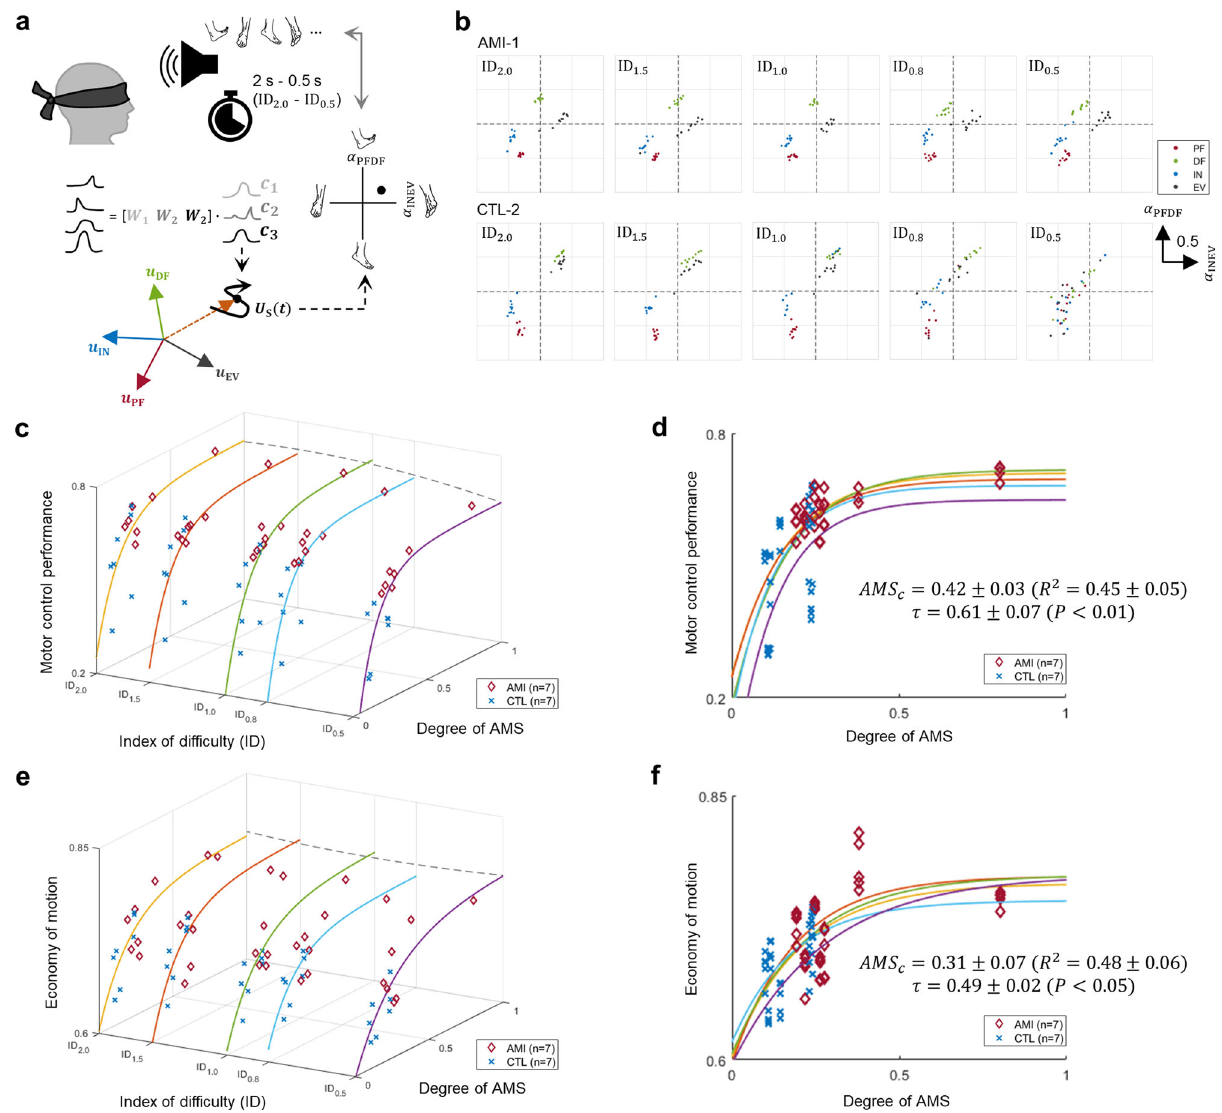
Fig. 4 Spatiotemporal motor control under time constraints. In a , an illustration is shown of a subject performing randomized, discrete ankle and subtalar joint motion tasks under varying time constraint (2 – 0.5 s), or index of dif fi culty (ID 2 : 0 – ID 0 : 5 ). To decode motor intentions of recorded motor outputs, fi rst, synergy activations ( c - c ) are calculated using the muscle synergies ( W - W ) previously identi fi ed during 4 discrete motion testing of plantar fl exion (PF), 1 3 1 3 dorsi fl exion (DF), inversion (IN), and eversion (EV). Finally, directionality of motor intentions in an ankle joint ( α PFDF ) and subtalar joint ( α INEV ) are ; u computed based on the average vectors of synergy activation pro fi les for the 4 discrete movements u , u , u and the synergy activation vector of PF DF IN EV recorded motor outputs ( U S = [ c 1 , c 2 , c 3 ]). In b , motor control performance is shown for two representative subjects in α -space ( α PFDF and α INEV ). The Agonist-antagonist Myoneural Interface (AMI) subject maintained all 4 discrete movements up to the highest dif fi culty level with time constraint (0.5 s, ID 0 : 5 ). In contrast, the non-AMI control (CTL) subject started to lose boundaries at ID 0 : 8 and completely lost them at ID 0 : 5 . Relationships are shown in c and d between the motor control performance and the degree of agonist-antagonist muscle strain (AMS) in a combined analysis of affected AMI and CTL limbs ( n = 14) at all IDs. Further, relationships are shown in e and f between the economy of motion and the degree of AMS using a similar combined analysis ( n = 14). Motor control performance and the economy of motion were evaluated by the error and straightness of motor control traces to the target motor tasks. Kendall ’ s tau coef fi cients ( τ ), P , R 2 , and the Jackknife mean and s.d. of a critical degree of AMS ( AMS c ) are